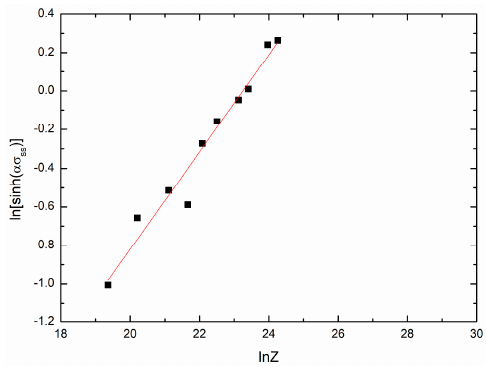
ασ ln[sinh( )] and ln Z . ασ ss ln[sinh( )] and ln Z . ss